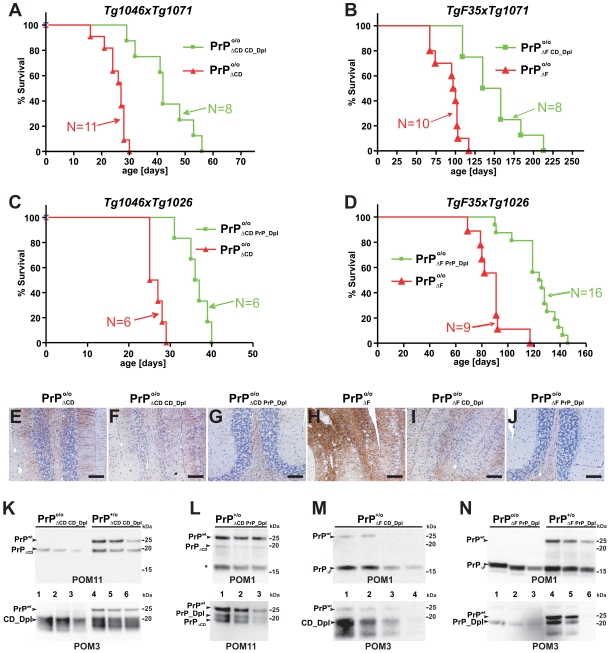
Survival of compound transgenic mice.Survival of compound transgenic mice derived from intercrosses between the transgenic lines described above. (A–D) Survival curves of mice lacking PrPC and expressing various transgenes (PrPΔF, PrPΔCD, CD_Dpl, PrP_Dpl) as indicated by the subscripts. Each line summarizes the survival animals with the respective genotype (group size: 6–16 as indicated). (E–J) Comparison of histopathological phenotypes in terminally sick PrP and PrP mice with their respective age matched compound littermate transgenic mice. All pictures show GFAP-immunostained cerebellar sections at identical magnification. Terminally sick Tg1046 PrP mice showed astrogliosis both in cerebellar cortex and white matter (E). Milder changes were present in Tg1046×Tg1071 PrP (F) and Tg1046×Tg1026 PrP mice (G). Subtotal granule cell loss associated with severe astrogliosis was seen in the cerebellum of TgF35 PrP mice (H). However, granule cell loss and astrogliosis was less severe in TgF35×Tg1071 PrP mice (I) and almost absent from TgF35×Tg1026 PrP mice (J). Scale bar = 5 µm. (K–N) Brain expression of PrPC and transgenic PrP deletion mutant as well as PrP/Dpl fusion proteins. Specific bands are indicated with arrowheads (K) The expression of CD_Dpl was higher than that of PrPΔCD and PrPC. Lanes 1–3 represent a serial dilution of a Tg1046×Tg1071 PrP mouse compared to a PrP mouse (lanes 4–6). (L) PrP_Dpl expression is similar to that of PrPΔCD and significantly lower than that of PrPC. Lanes 1–3 represent serial dilutions of Tg1046×Tg1026 PrP mice. The asterisk indicates a carboxy terminal fragment formed from wild-type PrPC. (M) Indirect comparison indicates similar PrPΔF and CD_Dpl levels in TgF35×Tg1071 PrP mice which were higher than those of PrPC. Lanes 1–4 depict a serial dilution of a TgF35×Tg1071 PrP mouse. (N) PrP_Dpl was less abundant than PrPΔF in TgF35×Tg1026 PrP and TgF35×Tg1026 PrP mice. Lanes 1–3 depict a serial dilution of a TgF35×Tg1026 PrP mouse compared to a TgF35×Tg1026 PrP mouse (lanes 4–6). All brain homogenates were treated with PNGase F, and replica western blots were decorated with antibodies POM1, POM3, and POM11 as indicated below each blot.